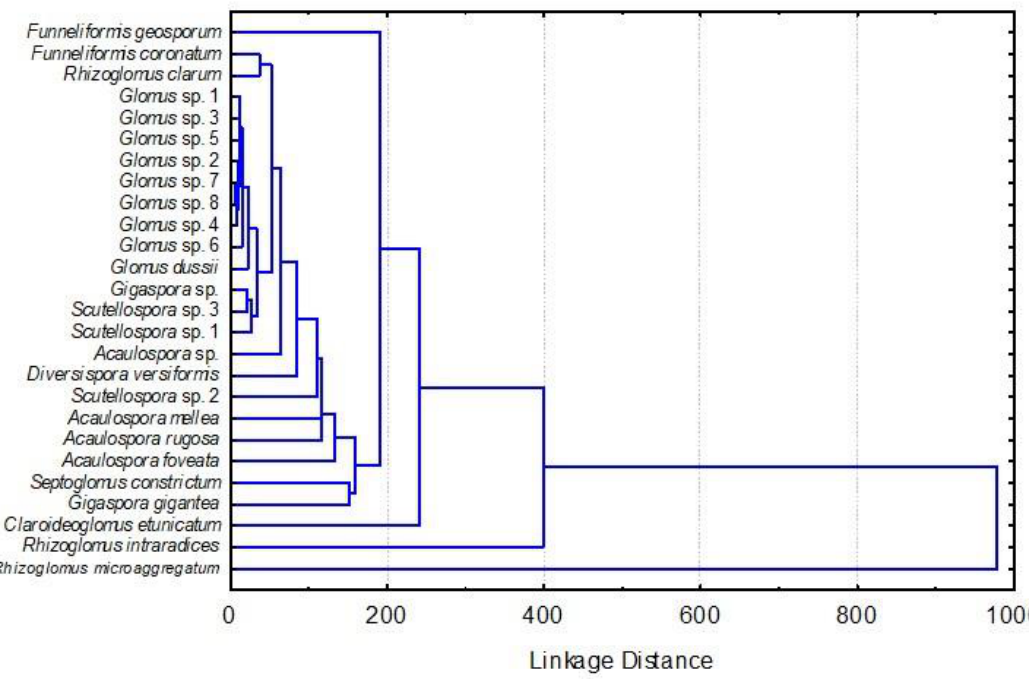
Figure 1. Dendrogram of the hierarchical conglomerate analysis performed using the arbuscular mycorrhizal fungi morpho-species groups. Table 3. Spore abundance of AMF species found at field sites with coffee. Species